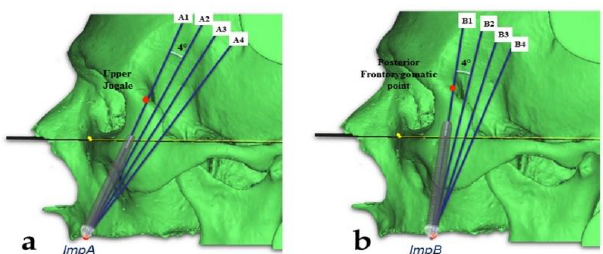
Figure 2. ( a ) Sagittal planes drawn clockwise, rotating by 0, 4, 8, and 12° from the upper jugale on the ImpA points for the anterior zygomatic implant trajectory. ( b ) Sagittal planes drawn clockwise, rotating by 0, 4, 8, and 12° from the posterior frontozygomatic point on the ImpB points for the posterior trajectory.